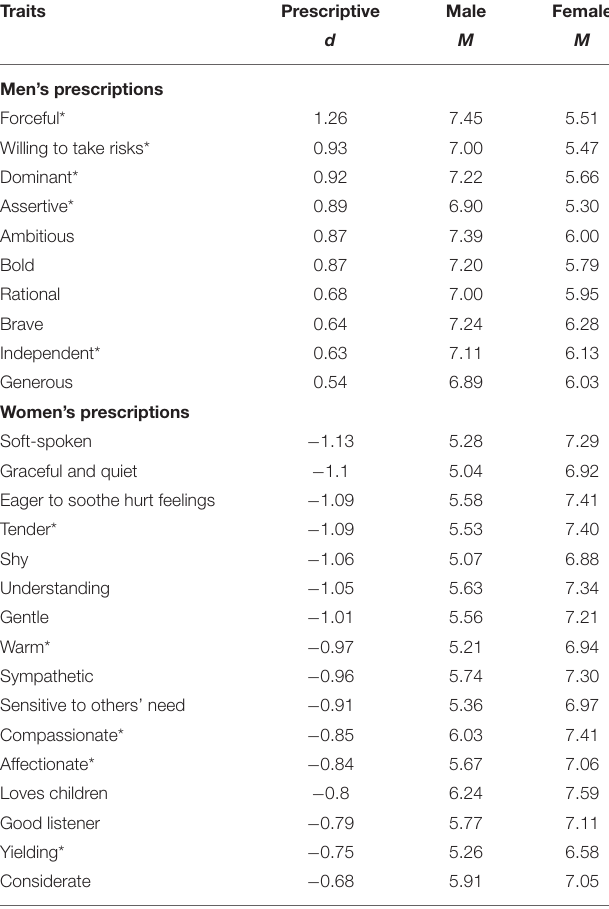
TABLE 1 | Prescriptive traits for men and women in China in Study 1. Traits Prescriptive Male